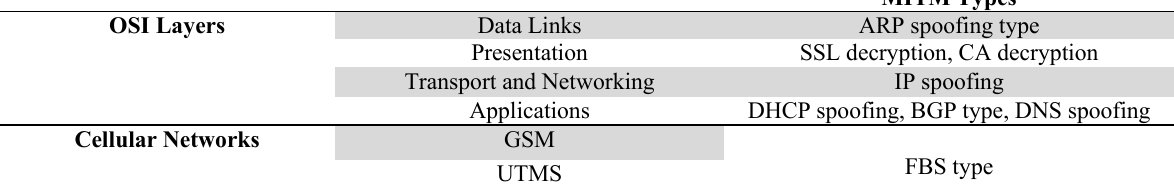
MITM attacks on different communication